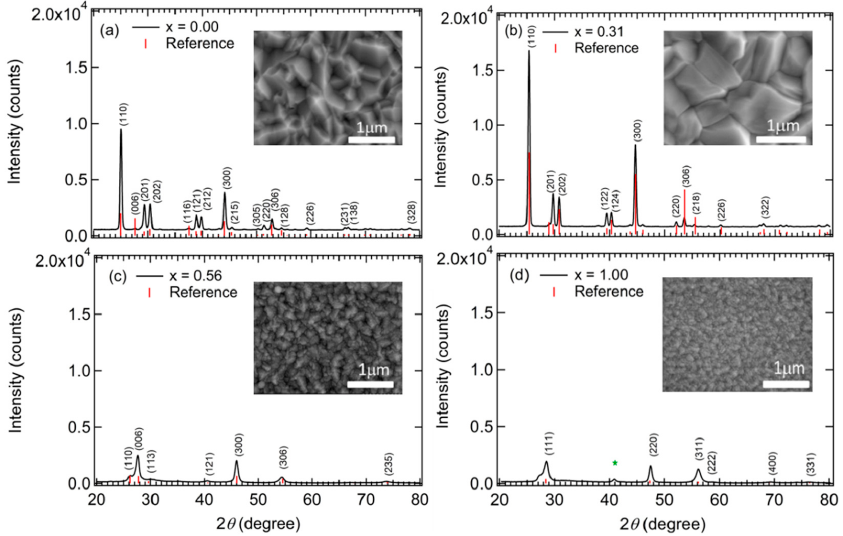
Figure 1. X-ray diffraction (XRD) patterns for ~9000 Å thick IGS films of different alloy composition values x . The XRD patterns are consistent with expectations for (In 1 − x Ga x ) 2 Se 3 obtained from MDI JADE: ( a ) PDF # 97-064-0476; ( b ) PDF # 97-063-4424; ( c ) PDF # 97-009-2068 and ( d ) PDF # 97-007-6754.